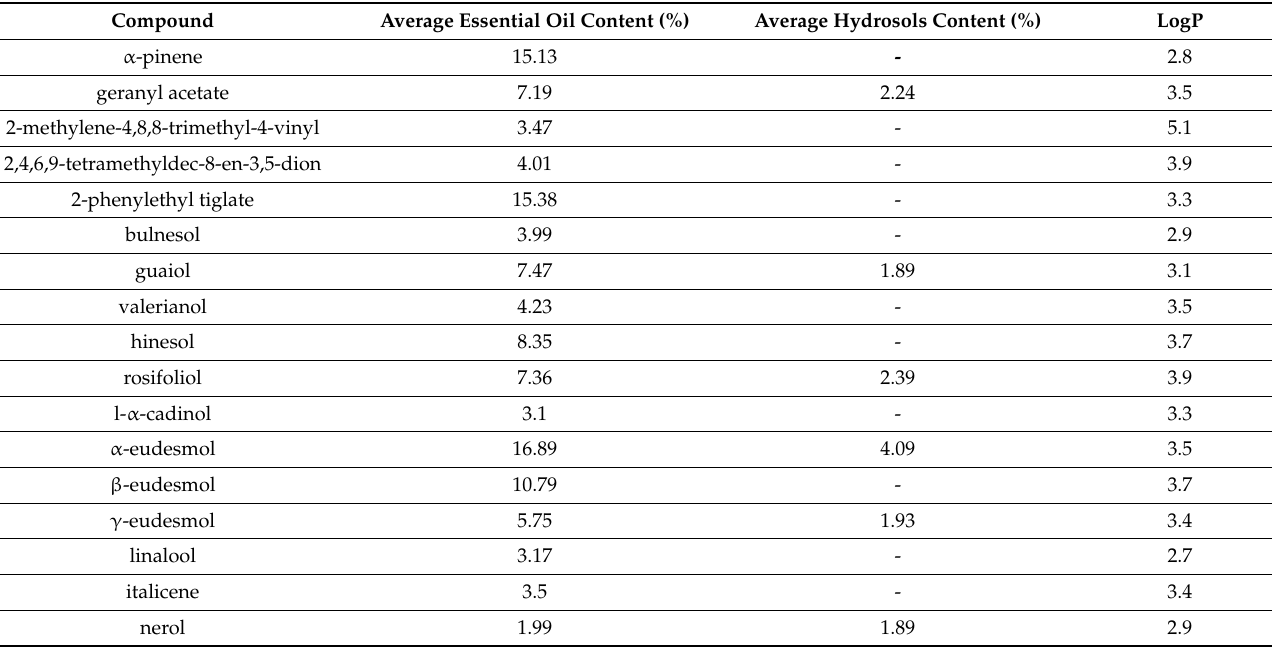
Table 3. Comparison of essential oils and hydrosols of immortelle plant ( H. italicum ) content for the average amount of compounds that occurred in the essential oil in a relative peak area greater than 3%. LogP values were read from the PubChem web portal [18].